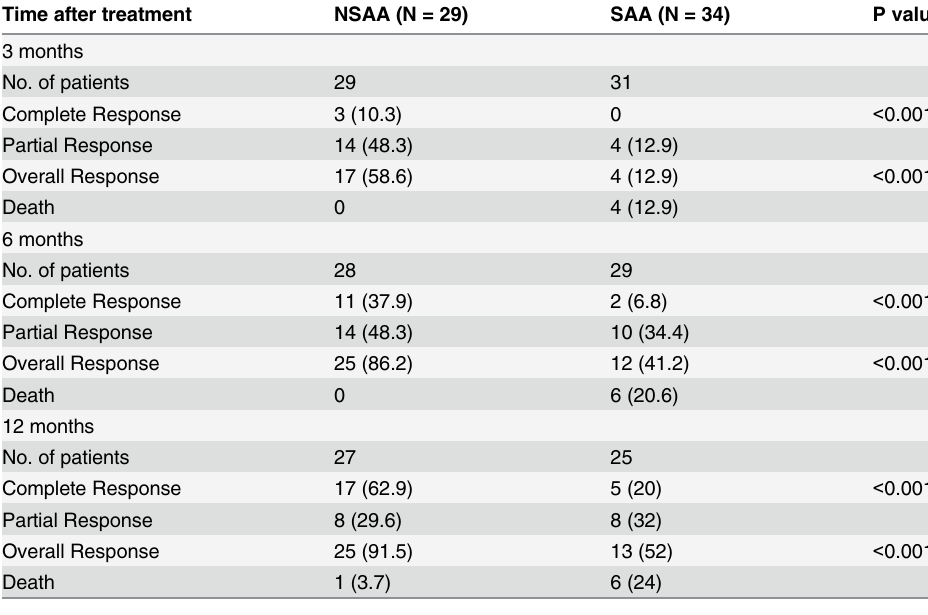
Table 2. Response to treatment and death at 3, 6 and 12 months after treatment. Time after treatment NSAA (N =